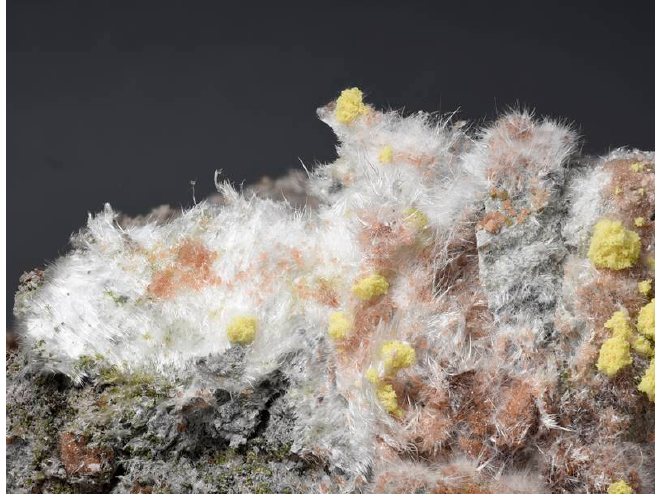
Figure 13. Halotrichite, as hairy acicular crystals, up to 7 mm in length, with römerite, greenish voltaite, and a tertiary copiapite group mineral from the Fornovolasco mine.